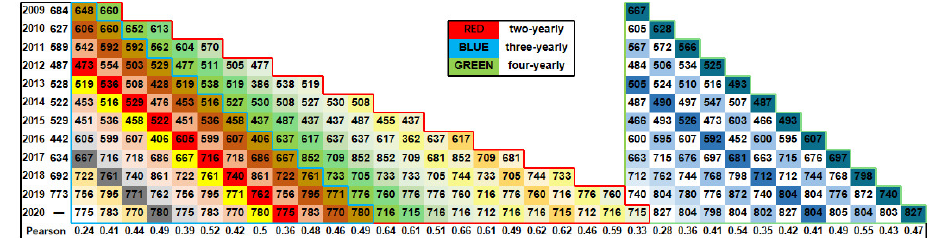
Figure 7. Rolling annual forecast results generation graph for accident numbers.